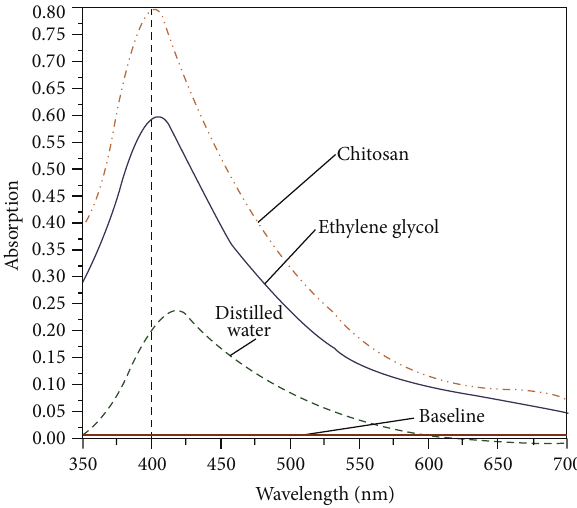
Figure 2: UV-visible absorption spectra of Ag-NPs prepared for 30 min ablation times in EG, chitosan, and DW.